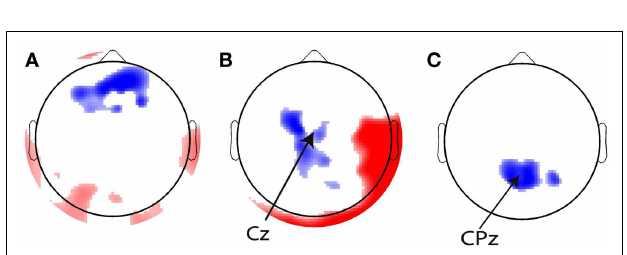
FIGURE 8 |Topographical overviews of the 10% most significant electrodes for the (A) eye blink, (B) stimulus, and (C) response regressors. Red and blue reflect positive and negative regression weights, respectively, and the intensity of the shading indicates the magnitude of the regression weights.The most significant electrodes are in the locations from which the regressors were generated [indicated with arrows in (B,C) ].